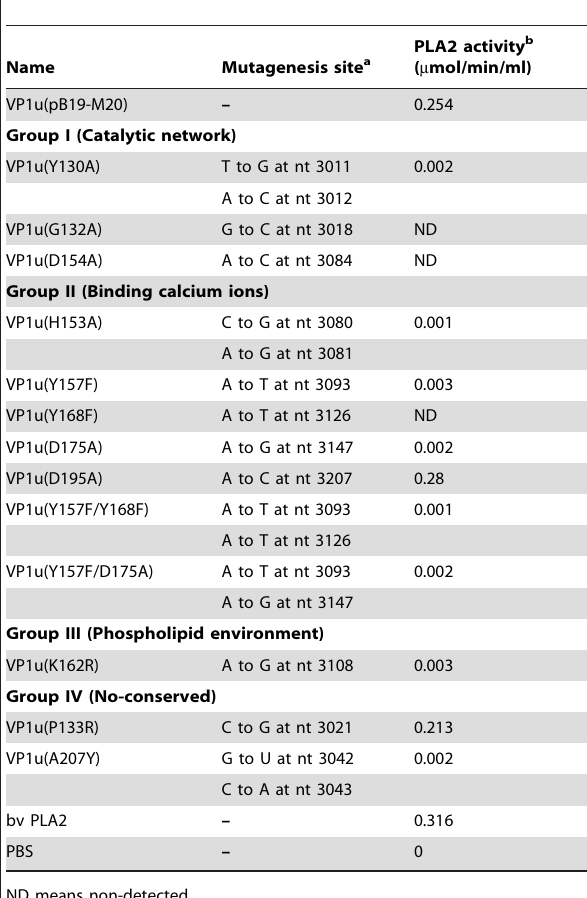
Table 1. Influences of mutations on secreted PLA2 (PLA2)